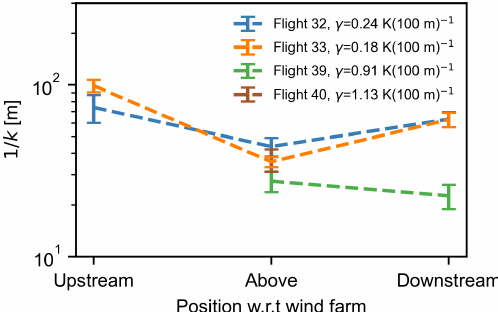
Figure 11. Dominant entrainment length scales of (cid:104) u (cid:48) w (cid:48) (cid:105) at differ- ent positions around the wind farms clusters. These measurements were recorded at about 60m above the rotor top tip in these wind farms. Note that there are no upstream data points for flight 39 and no upstream and downstream points for flight 40 due to negligible momentum entrainment at these positions. Error bars represent the stand error of the